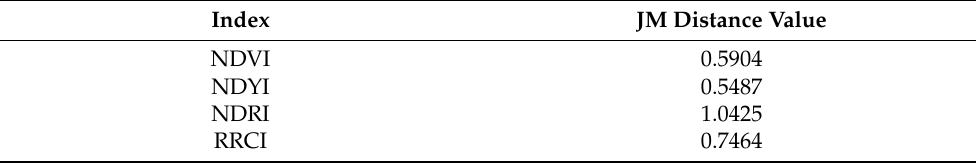
Table 5. JM distance between rapeseed and other vegetation in different vegetation